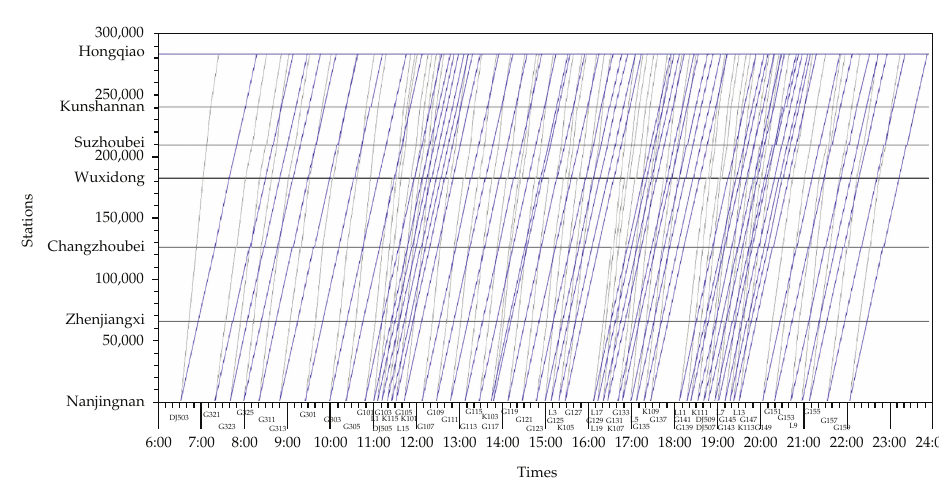
Figure 5: Timetable of speed restriction in all sections.